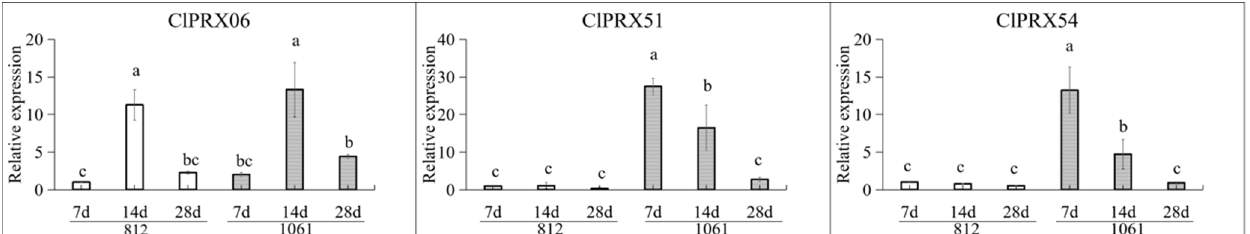
Figure 12. Expression levels of candidate ClPRXs in different developmental stages of peel. The values represent the means ± SDs, and different bars indicate significant differences ( p < 0.05) of genes’ expression level. Statistical letters (a, b, c, and bc) indicate the significant differences of relative expression of genes in “812” and “1061” watermelon materials.